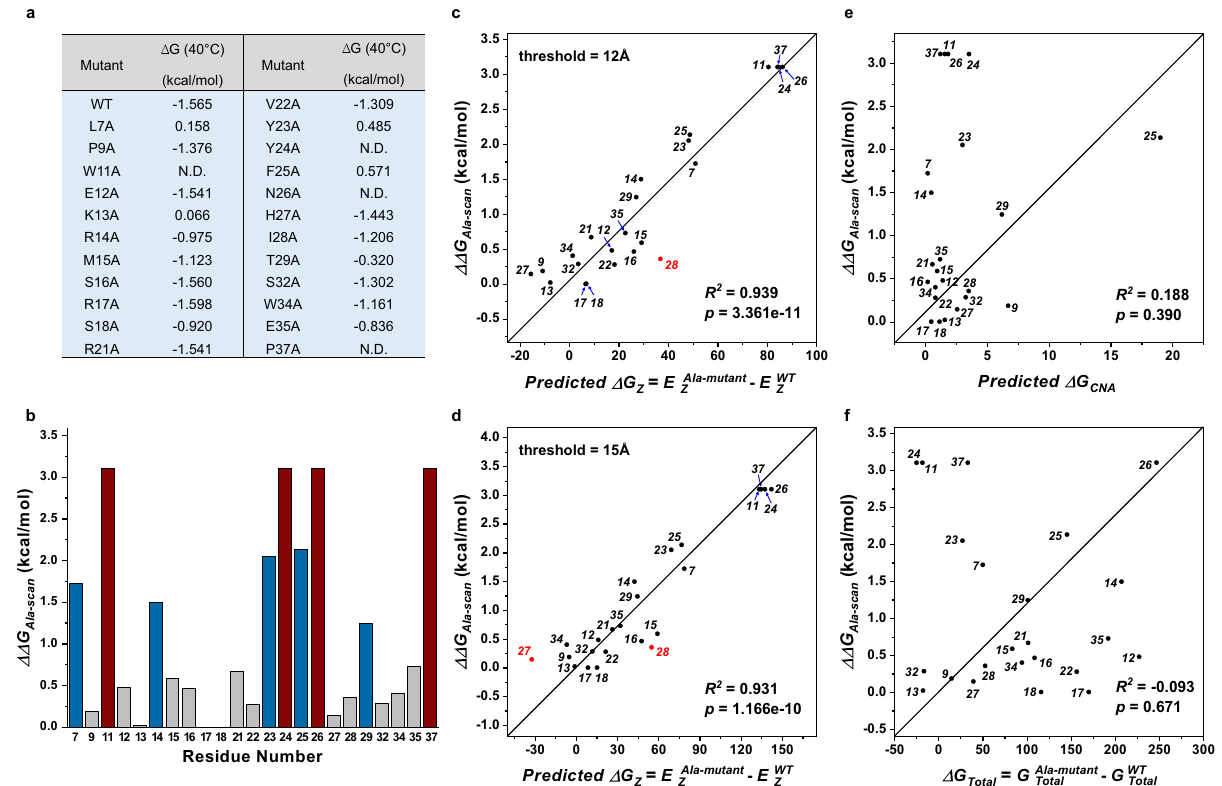
Fig. 6 Evaluations of free energy score calculation performance of the NRI-based approach. a Summary of thermodynamic data for the WT and 23 Ala- mutants of Pin1. N.D., not determined, represents that the mutant is too unstable to measure. b Effects of the Ala mutations on the equilibrium stability of Pin1. A positive value of ( ΔΔ G ¼ Δ G Ala (cid:2) mu tan t (cid:2) Δ G WT ) indicates that the Ala mutation is destabilizing relative to the wild type. Mutations that destabilize more than 3 kcal/mol ( ΔΔ G (cid:3) 3 kcal = mol ) are shown as red bars, more than 1 kcal/mol and less than 3 kcal/mol (1 (cid:4) ΔΔ G (cid:4) 3 kcal = mol ) are shown as blue bars. c , d Correlation between the computed free energy score ( Δ G Z ¼ E Ala (cid:2) mu tan t z (cid:2) E WT z ) and ΔΔ G from the chemical denaturation experiments for the 23 Ala-mutants of Pin1. Based on the position vector of C α in Pin1 (PDB ID: 1PIN), the threshold of residue-residue distance was set to 12 Å ( c ) and 15 Å ( d ) to present the residue-level interaction. e The correlation between the predicted Δ G CNA (Eq. (3) in Supplementary Note 3) and ΔΔ G for the 23 Ala-mutants of Pin1. f Correlation between the Δ G Total ¼ G Ala (cid:2) mu tan t Total (cid:2) G WT Total obtained from MD simulations and ΔΔ G for the 23 Ala-mutants of Pin1. The Pearson correlation coef fi cient and p-value were calculated by scipy.stats.pearsonr in Python package. The p-value was computed by two-sided test and no adjustment was made for multiple comparison. The degree of freedom ( df ¼ n (cid:2) 2) is